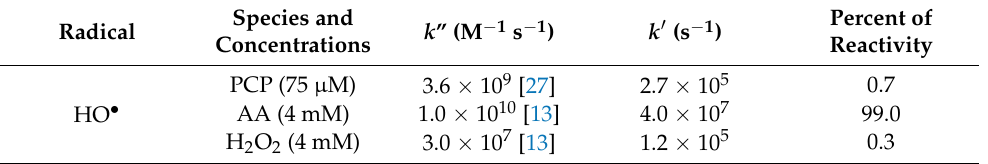
Figure 3. Effect of different [H 2 O 2 ]/ascorbic acid (AA) ratio on the degradation of PCP (20 mg L − 1 ) in the presence of 0.5 g L − 1 of magnetite at pH 7.2 (total solution volume = 100 mL). [PCP] represents the PCP concentration after oxidation at a specified oxidation time and [PCP] 0 is its concentration at t = 0 (before treatment) determined by HPLC. Table 2. Reactivity of hydroxyl radicals with species present in the aqueous Fe 3 O 4 /AA/H 2 O 2